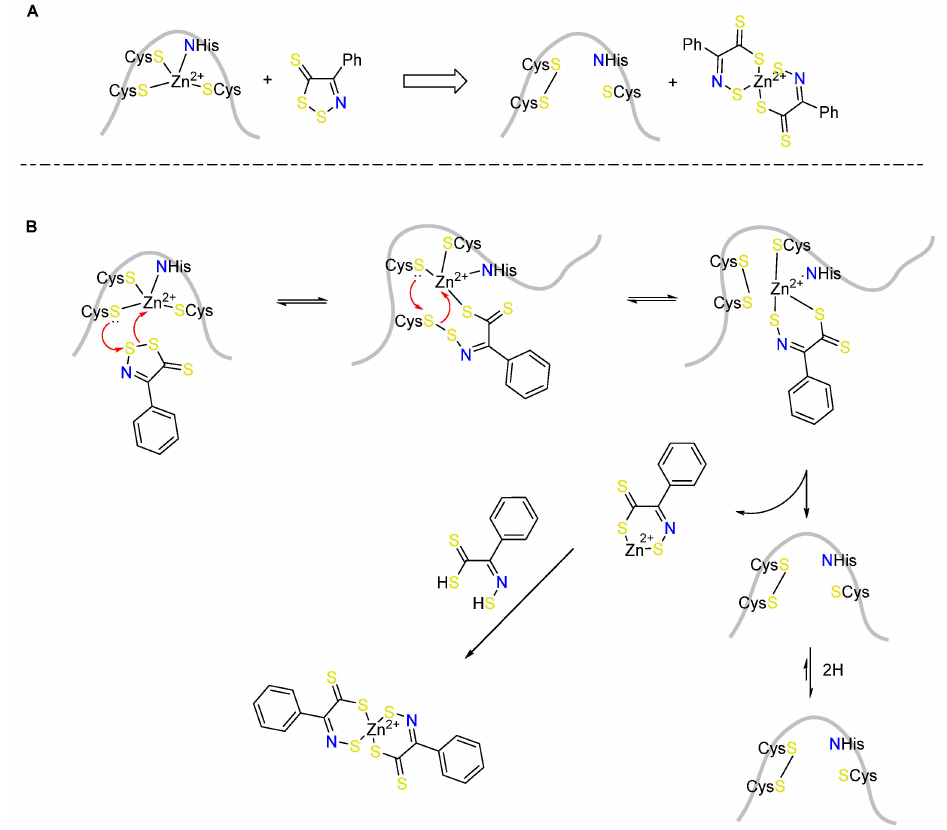
Figure 22. Proposed redox mechanism for 1,2,3-dithiazoles mediated zinc ejection of the FIV nucleo- capsid protein. ( A ) Summary of reaction; ( B ) Detailed reaction pathway analysis.